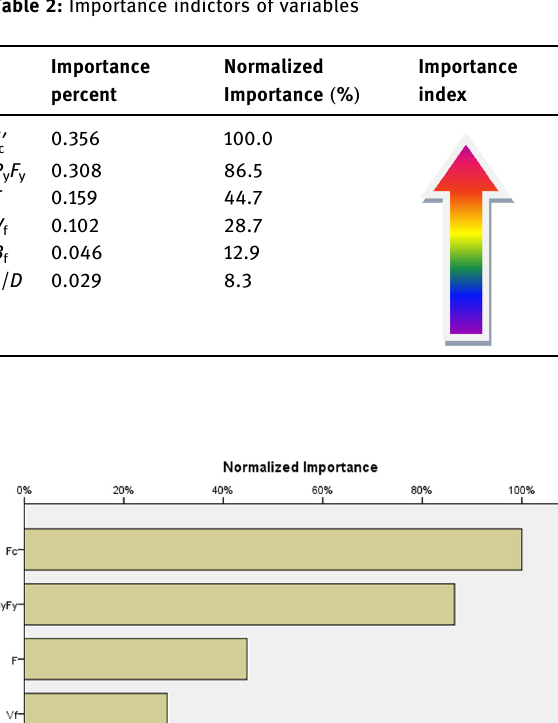
Table 2: Importance indictors of variables